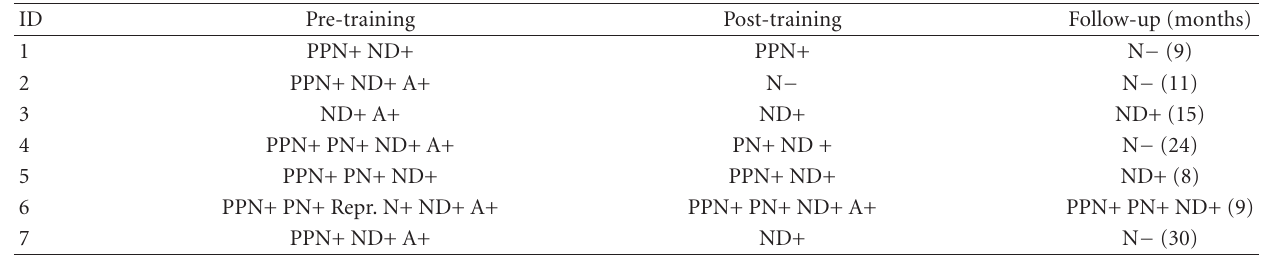
Table 3: Clinical neglect evaluation at pre-training, post-training, and follow-up evaluation.